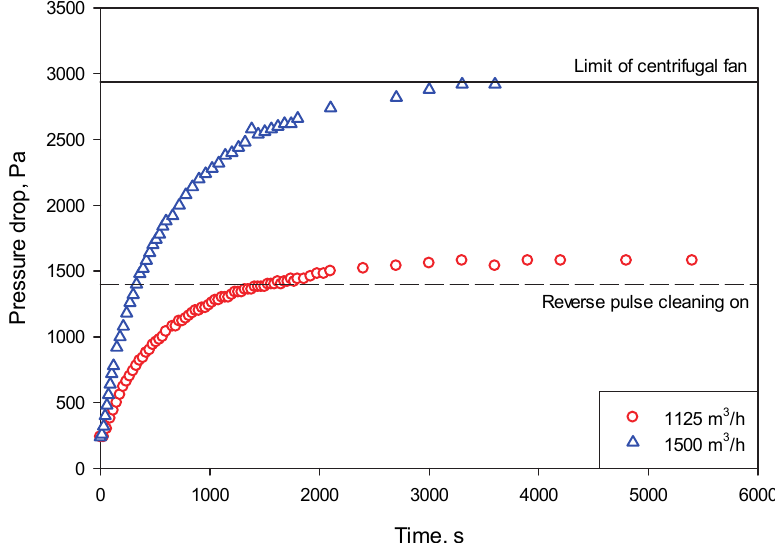
Fig. 4 Development of the pressure drop across the filter following start-up of FePO (circles) and 1500 m 3 /h (triangles) volume flow. A stable operation line is obtained for the smaller flow rate, while the pressure drop for 1500 m 3 /h reaches the suction limit of the centrifugal fan even though reverse-pulse clean- ing starts at 1400 Pa.